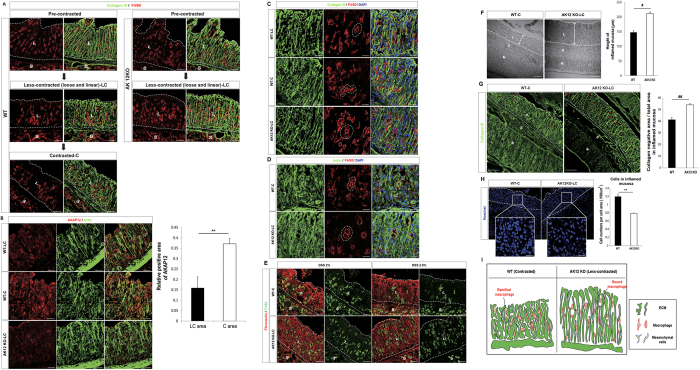
AKAP12+ CMCs mediated tissue contraction promotes ramified macrophages.(A) Immunostaining for Collagen III and F4/80 in inflamed colon mucosa of WT and AKAP12KO mice. Pre-contracted, less-contracted and contracted areas were selected according to state of collagen structure. Bars: 50 μm. (B) Immunostaining for AKAP12 and actin in WT and AKAP12 KO inflamed colon. Bars: 25 μm. Relative AKAP12 positive area of contracted or less contracted mucosa in WT mice was measured by Image J. (n = 4 for contracted and n = 3 for less contracted mucosa). (C) Immunostaining for collagen III, F4/80 and cell nucleus showed that ramified macrophages were in contracted mucosa and rounded macrophages in less-contracted mucosa. Representative macrophages were indicated by dotted line along with its shapes. Bars: 25 μm. (D) Immunostaining for F4/80 and actin in WT and AKAP12 KO inflamed colon. Representative macrophages were indicated by dotted line along with its shapes. Bars: 25 μm. (E) Immunostaining for fibronectin and F4/80 in WT and AKAP12 KO inflamed colon. Bars: 50 μm. (F) Average vertical height of inflamed mucosa were measured (n = 9 or 7 for WT or AKAP12KO, respectively) (mean of 3 different sections used). Bars: 100 μm. (G) Proportion of collagen negative area to total area in mucosa was measured. Hollow pores in WT and AKAP12KO collagen structures were marked by red asterisk of different size (n = 6 per group) (mean of 2 technical replicates used). (H) Density of cells in mucosa were measured (n = 7 or 5 for WT or AKAP12KO, respectively) (mean of 2 different sections used). Bars: 20 μm. (I) Schematic images depicting shapes difference of macrophages between WT and AKAP12 KO inflamed colon mucosa. All imaging experiments were performed by confocal microscopy. L: lamina propria (mucosa), S: submucosa, M: muscularis externa. All panels, WT and AKAP12KO mice were given 2% DSS in their drinking water for 8d and were then allowed to recover with normal drinking water for 4d. All images are representative of at least 5 mice per group. P## < 10−6, P# < 10−4, P** < 10−2. Error bars, s.e.m.